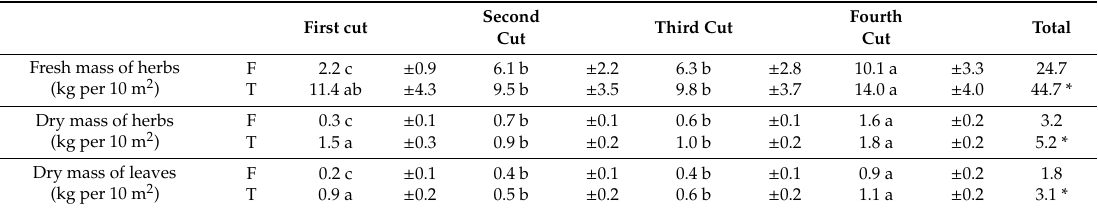
Table 3. Yield of raw